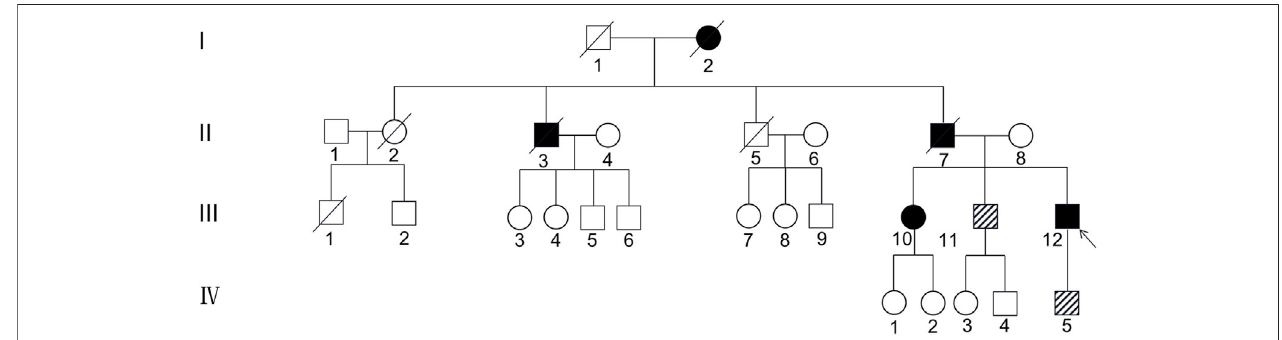
FIGURE1| Pedigreeofthe fi rstHanChinesefamilywithCSF1R-microglialencephalopathy.TheRomannumeraltotheleftofthepedigreedenotesthegeneration. Womenarerepresentedbycircles,andmenbysquares.Thearrowindicatestheproband(patientIII-12).Blacksymbolsrepresentaffectedpatients,whilewhitesymbols represent unaffected individuals or at-risk individuals of unknown phenotype. Oblique symbols represent that the patients with CSF1R mutation were asymptomatic.